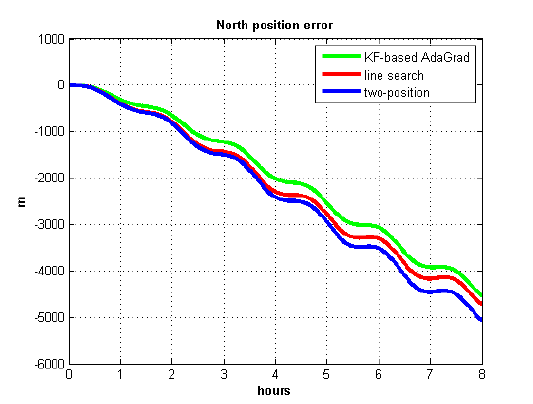
Figure 13. East position error.